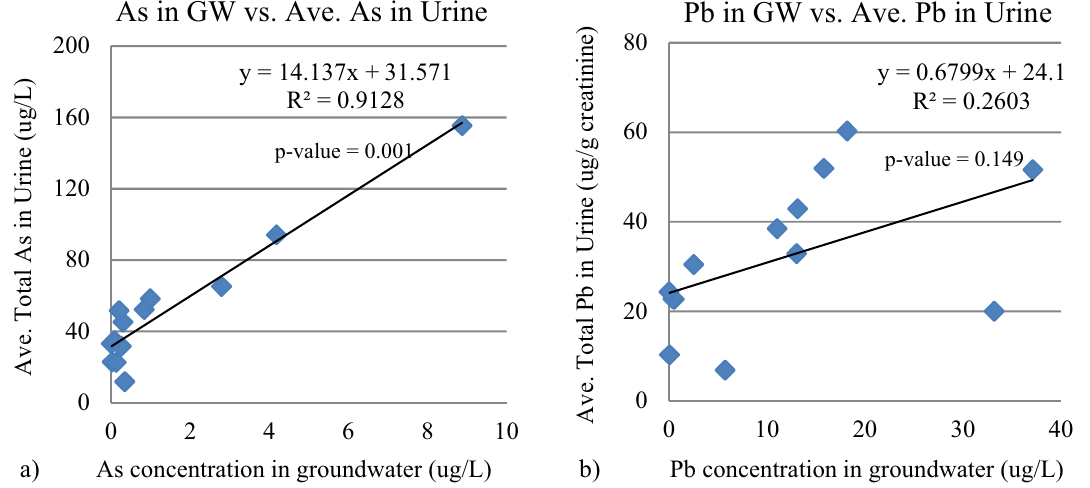
Figure 4. Linear relationship between the ( a ) As and ( b ) Pb levels in the urine of the SGWC group and in the groundwater